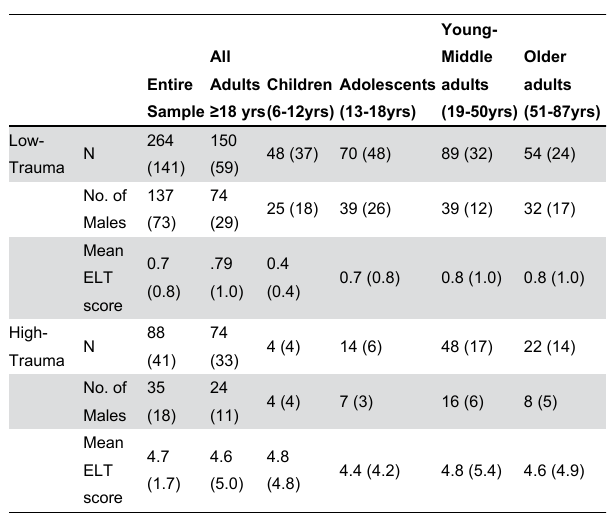
Table 1. Demographic information for the ‘Low-Trauma’ and ‘High-Trauma’ exposure groups across the whole sample and each individual age